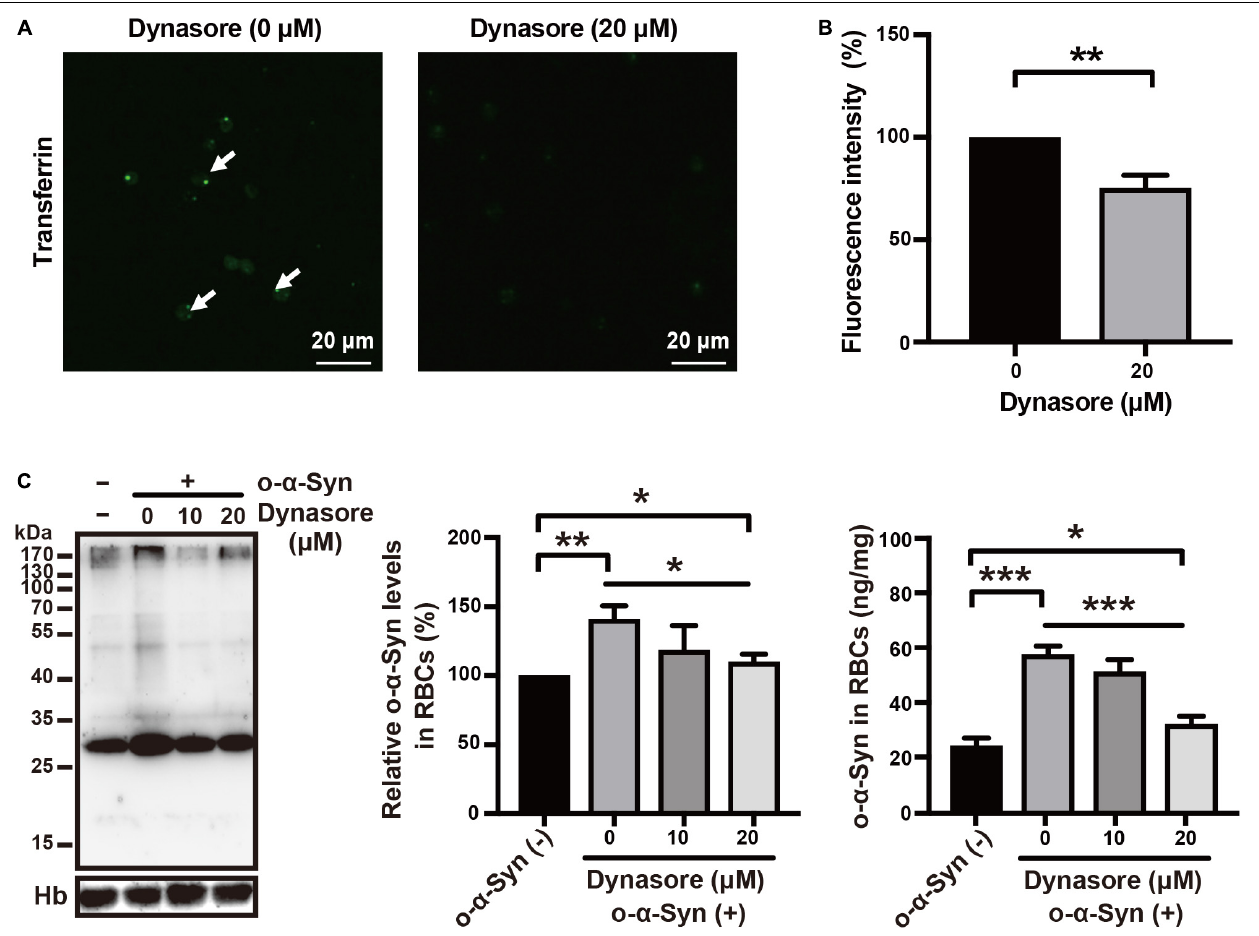
FIGURE 6 | Effect of dynasore on o- α -Syn transport into RBCs. (A,B) RBCs were untreated or pretreated with 20 µ M of dynasore, and then incubated with 10 µ g/mL fluorescein-labeled transferrin for 2 h. In dynasore-treated cells, the endocytosis of fluorescein-labeled transferrin was inhibited, which was in contrast to the untreated cells. (C) Western blot and ELISA showing the changes of o- α -Syn levels in RBCs after pretreatment with dynasore and incubation with o- α -Syn. Intracellular o- α -Syn levels were significantly decreased in cells pretreated with dynasore. Values in non-o- α -Syn-treated cells were considered 100%. n = 3; * p < 0.05, ** p < 0.01, *** p < 0.001, **** p < 0.0001; Hb,